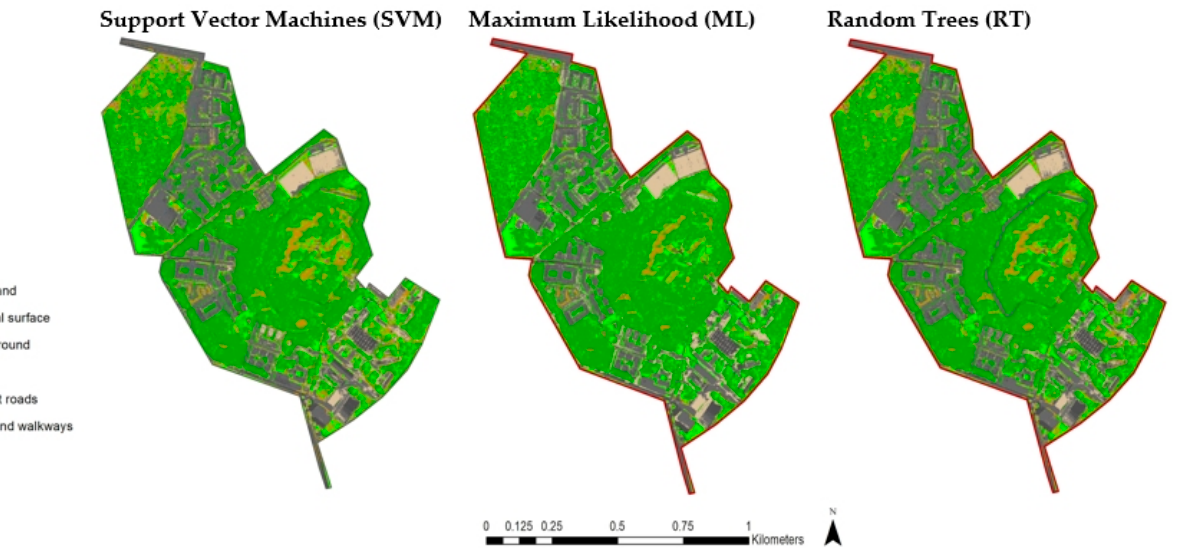
Table 4. RMSE for the classification of 7 class (LULC).